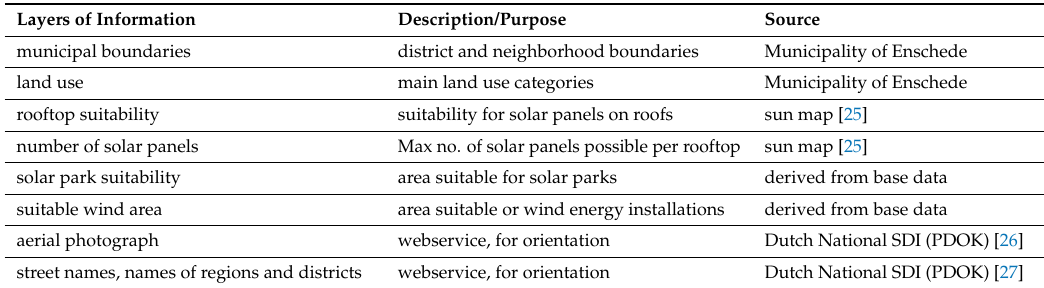
Table 2. Data layers shown on the maptable.